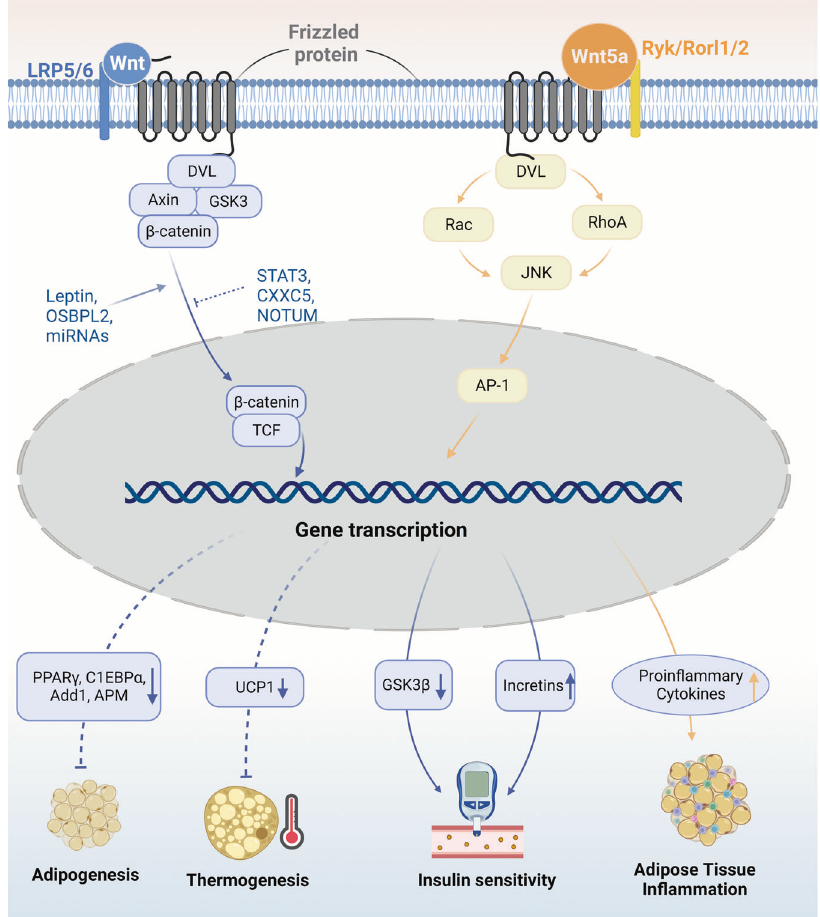
Fig. 4 Wnt/ β -catenin pathways in obesity pathogenesis. In the canonical Wnt pathway, upon activation by Wnt proteins, β -catenin is released and enters the nucleus as a transcription coactivator of TCF to regulate the transcription of target genes. The activation of Wnt/ β -catenin pathway leads to, (1) the supersession of adipogenesis by down-regulating the expression of PPAR γ , C1EBP α , Add1, APM, etc.; (2) the inhibition of BAT-related thermogenesis by down-regulating UCP-1; and (3) the increase of insulin sensitivity by down-regulating GSK3 β expression in CNS while up-regulating incretins within the small intestinal epithelium. The canonical Wnt signaling can be stimulated by factors including leptin, OSBPL2, and miRNAs like miR-23b, miR-148b miR-4269, and miR-4429. It can also be inhibited by JAK/STAT3 pathway, CXXC5, and NOTUM. These factors are all involved in the pathogenesis of obesity by regulating Wnt/ β -catenin signaling pathway. Additionally, Wnt5a, a part of the non-canonical Wnt pathway, induces obesity-associated in fl ammation in WAT in a JNK-dependent manner, which further contributes to the occurrence of insulin resistance in adipose